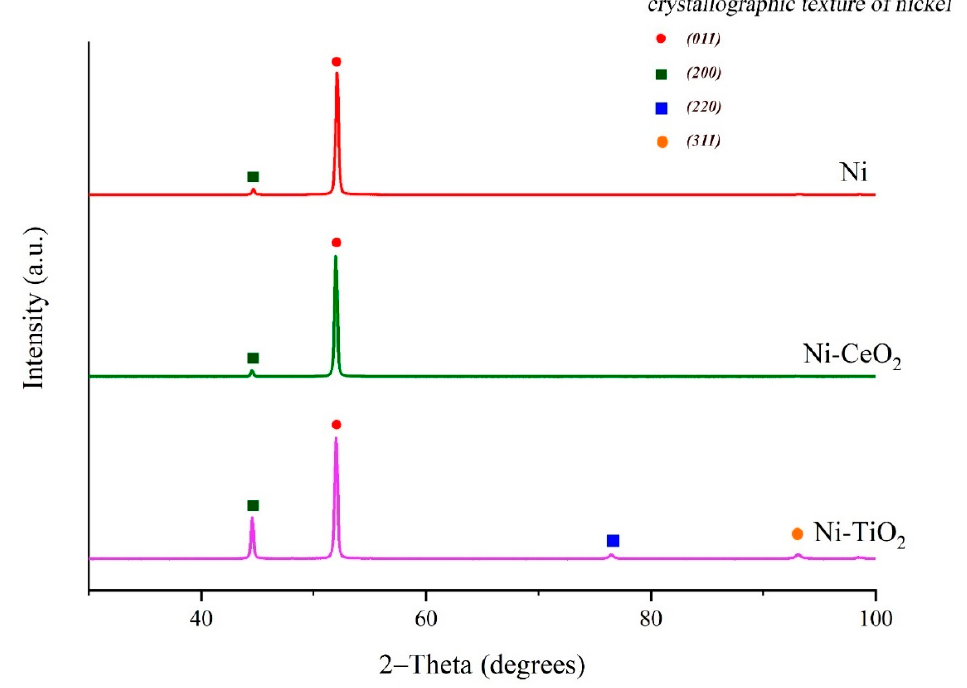
Figure 6. XRD patterns of Ni and composite Ni-CeO 2 and Ni-TiO 2 coatings .